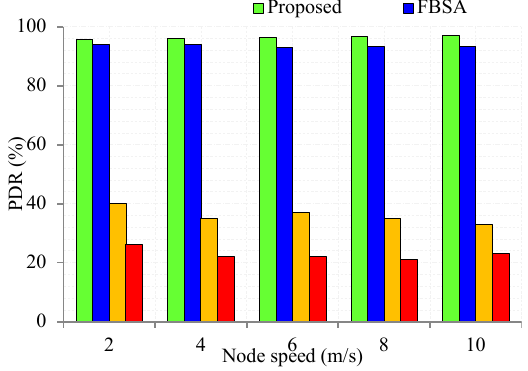
Figure 7 . Comparative analysis on